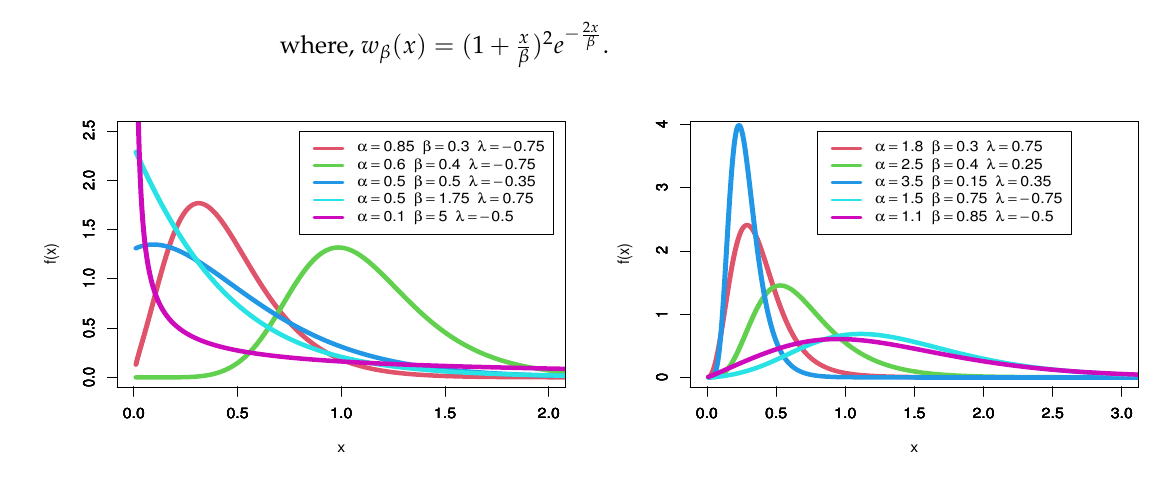
Figure 1. pdf of TT L LBE distribution. The TT L LBE model’s hazard rate plots are shown in Figure 2. The hrf can be take the following forms: J shape, unimodal, a constant shape, and decreasing and increasing shape.